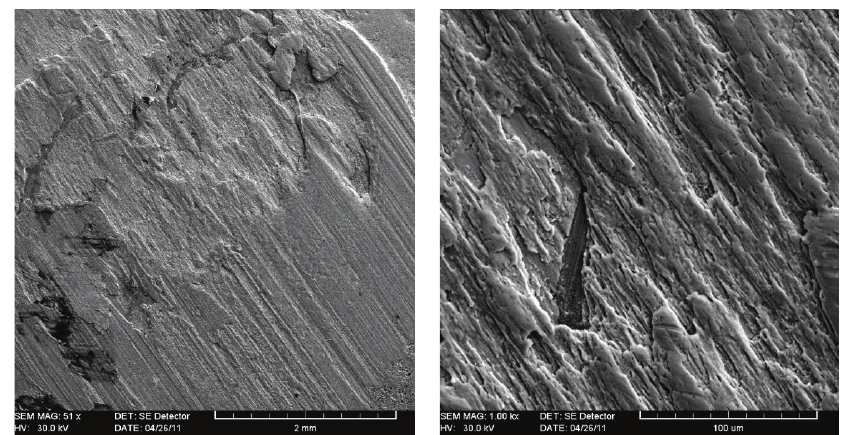
Figure 24: Fractured surface of Sn2La/Cu joint.